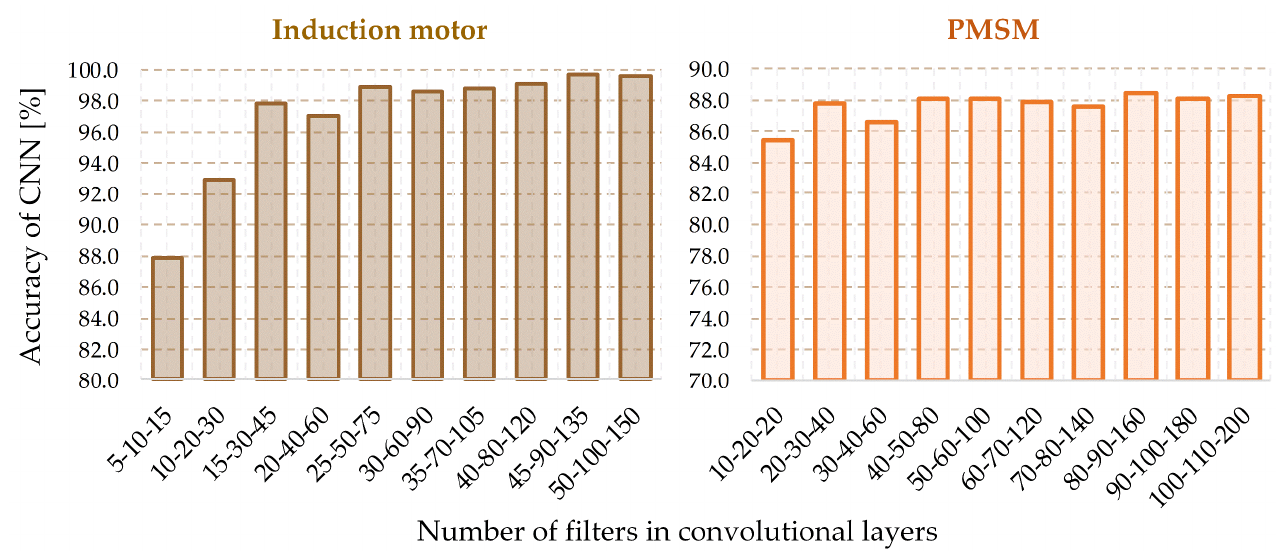
Energies 2022 , 15 , x FOR PEER REVIEW Figure 6. Influence of the number of CONV filters on CNN precision. Figure 6. Influence of the number of CONV filters on CNN precision.